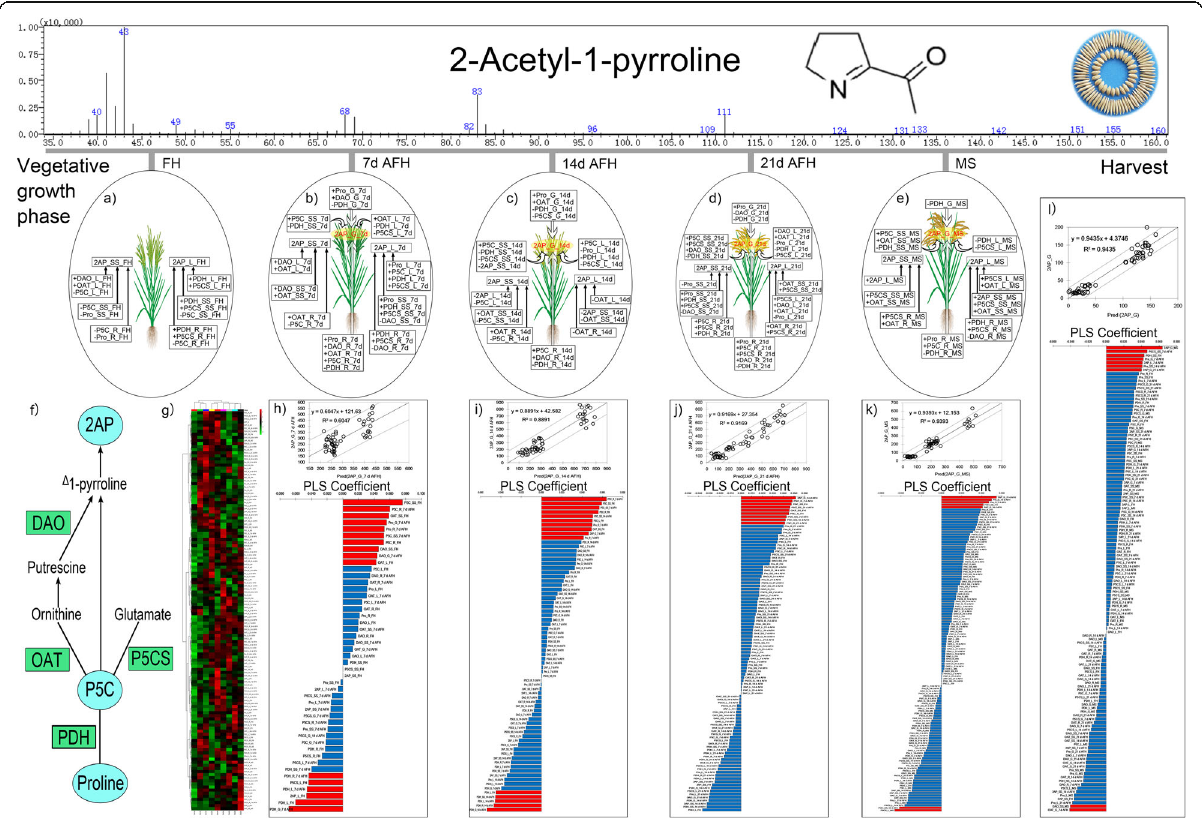
Fig. 1 The 2AP accumulation in stem-sheath, leaves and grain at different growth stages. 2AP: 2-acetyl-1-pyrroline, Pro: Proline, PDH: Proline dehydrogenase, P5CS: Pyrroline-5-carboxylic acid synthetase, OAT: Ornithine aminotransferase, P5C: 1-pyrroline-5-carboxylic acid, DAO: